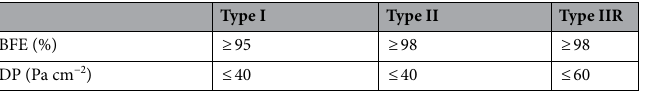
Table 1. Performance requirements for medical face masks according to EN 14683:2019.